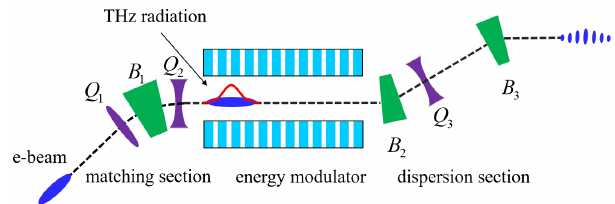
subpicosecond density modulation in relativistic electron beams with low-power THz seed radiation. B 1 , B 2 , and B 3 are sector dipole magnets; Q 1 , Q 2 , and Q 3 are quadrupole